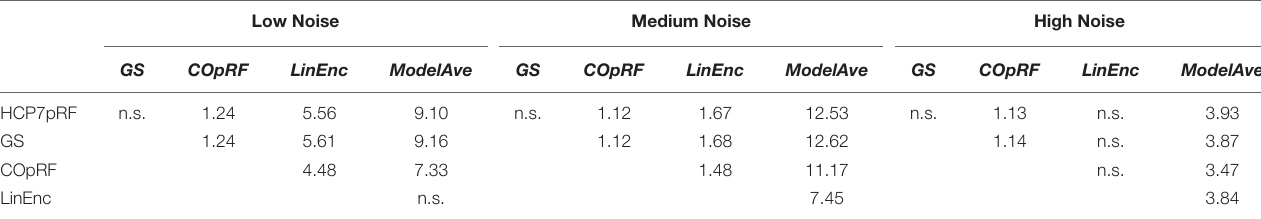
TABLE 2 | Pairwise comparison of the variability of the estimates of the pRF size between estimation methods at different levels of noise (narrow pRF: angle = 0.59 radians, eccentricity = 1.79 ◦ , pRF size σ = 0.23 ◦